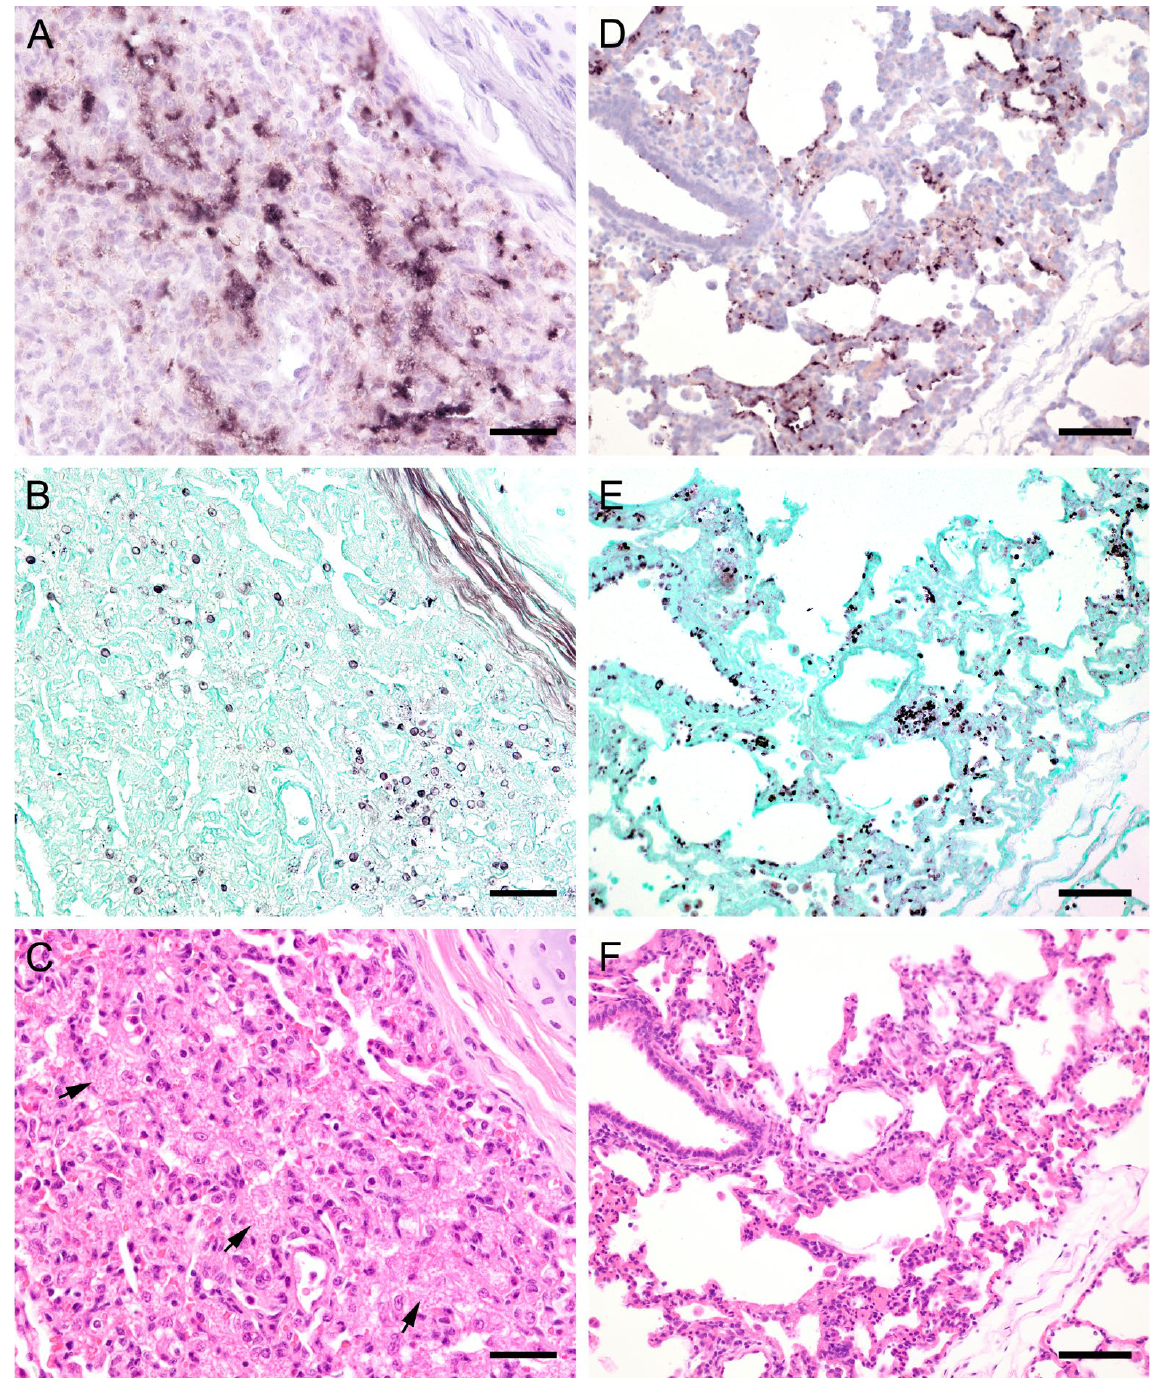
Figure 2. (see previous page). Adjacent sections from the same pig lung area of two different pigs with diffuse Pneumocystis spp. distribution over large areas are shown in comparison after ISH, GMS, and H&E staining. ( A ) ISH labels Pneumocystis organisms attached to the alveolar walls. Bar = 40 µ m; ( B ) Compared to the ISH-labeled organisms, the ratio of GMS-labeled cystic forms is higher. Bar = 40 µ m; ( C ) H&E staining reveals an interstitial pneumonia, the lung tissue is condensed. Pneumocystis organisms are arranged in chains (arrows). Bar = 40 µ m; ( D ) ISH reveals alveolar lining with fungal stages over large lung areas. Bar = 80 µ m; ( E ) In comparison with ISH, the number of GMS-stained asci is high. Bar = 80 µ m; ( F ) The alveoli are well shaped, and the tissue shows only a mild interstitial pneumonia. Bar = 80 µ